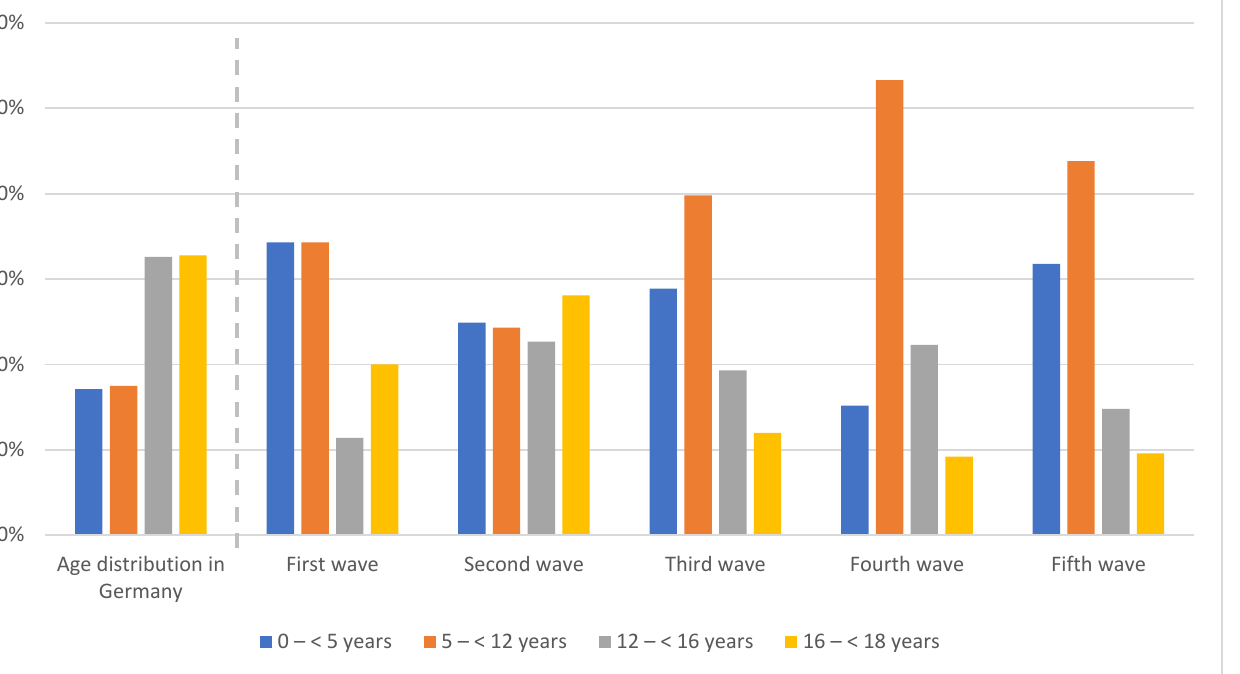
Figure 2. SARS-CoV-2-positive patients according to age group and wave in comparison to general age distribution in Germany [20] .